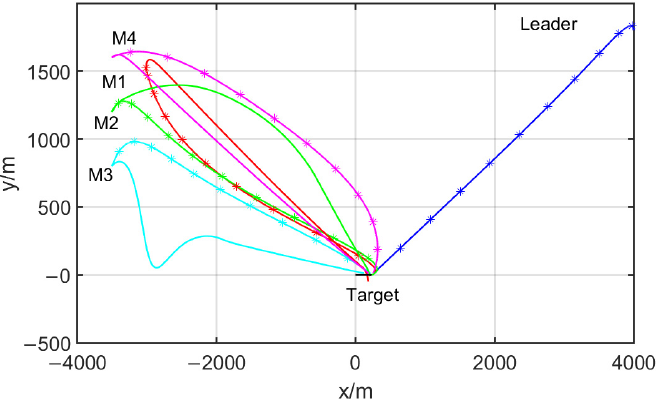
Figure 11. Projection of flight trajectory curve of cooperative attack on target 3 in the XOY plane.